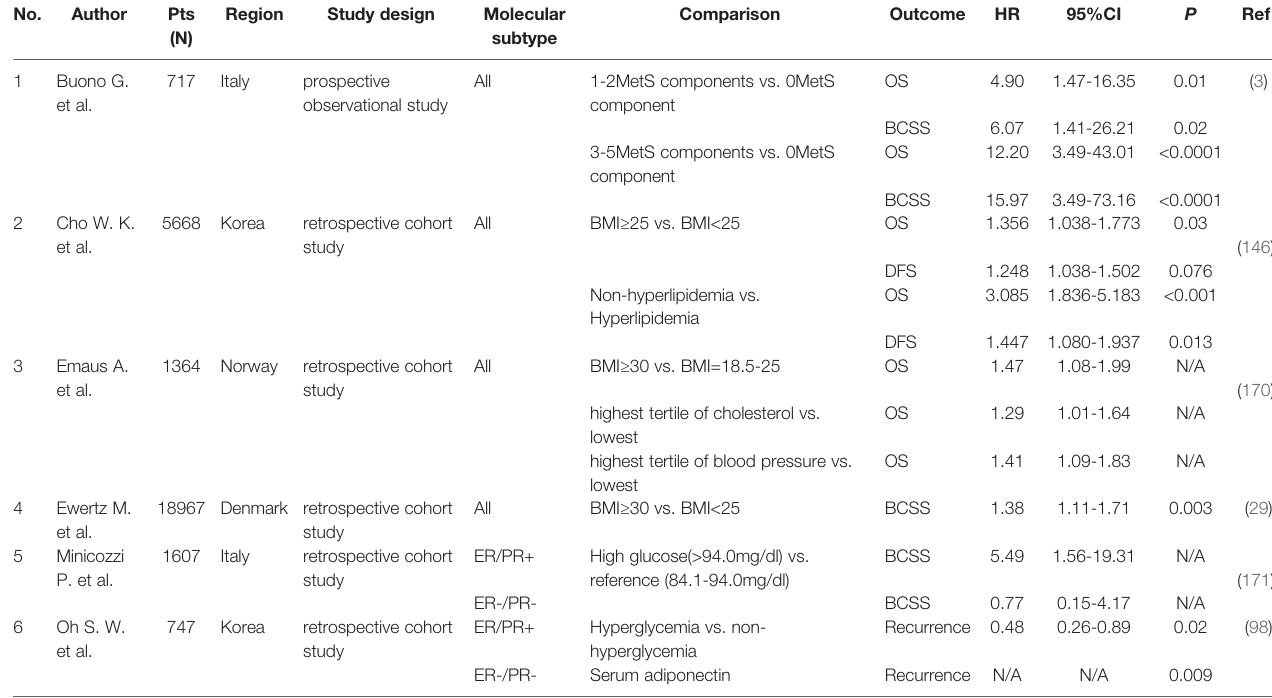
TABLE 2 | The effect of metabolic syndrome and its components on recurrence and survival of breast